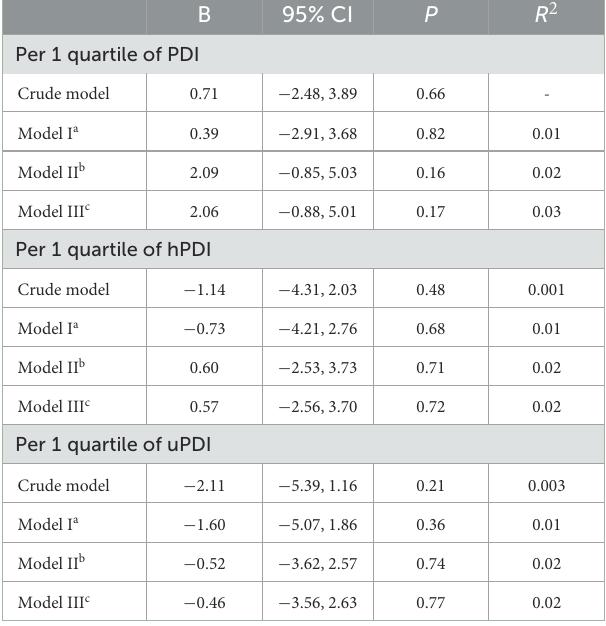
TABLE 4 Linear association of energy-adjusted plant-based diet indices with serum level of adropin (as a continues